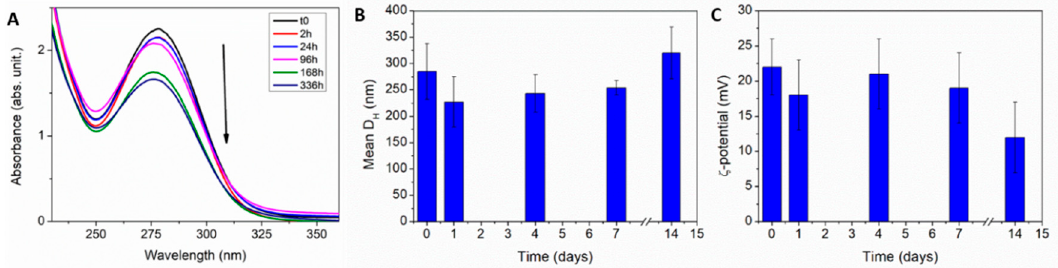
Figure 4. UV / Vis spectra ( A ), mean D H (main populations only) ( B ) and ξ -potential ( C ) vs. time of PolyCD@Ada-Rhod/DCF nanoassemblies in ultrapure water (0.5 mg/mL, [Ada-Rhod] = 8 µM, [DCF] = 236 µM). Data were acquired at t = 0, 1, 4, 7 and 14 days. Nanoassemblies dispersions were stored at 25 °C under stirring along the experimental time.